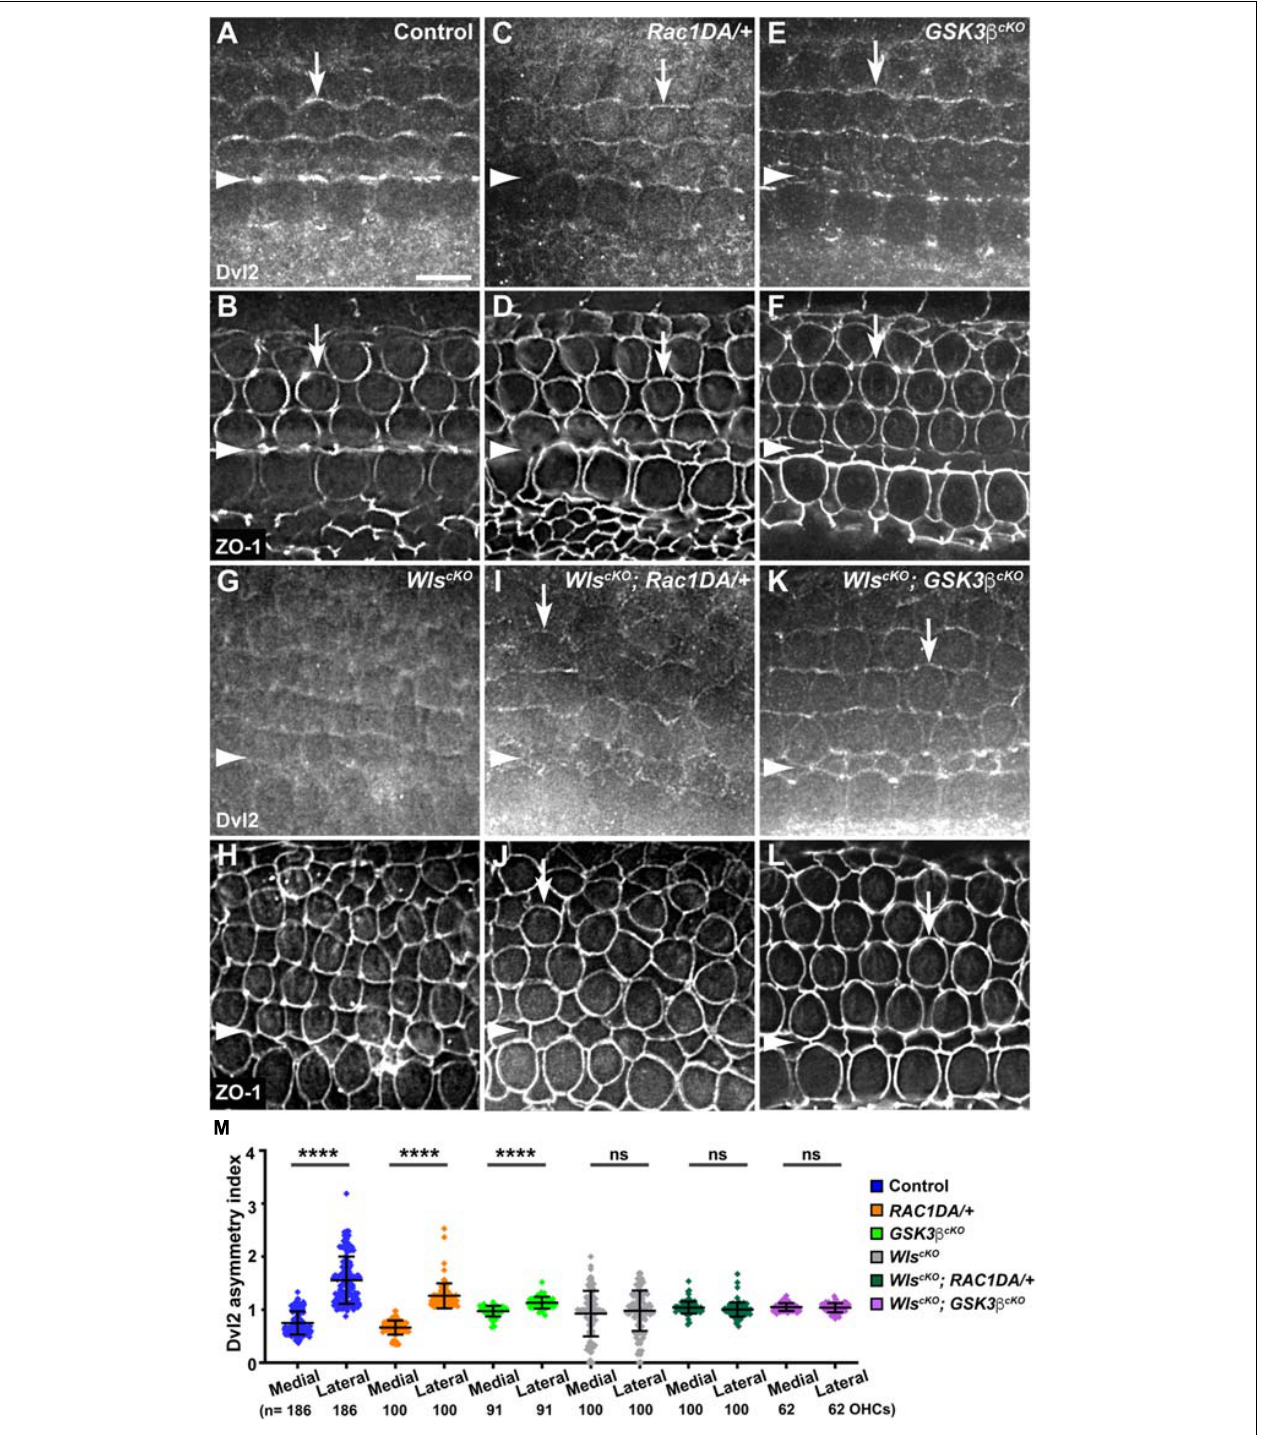
FIGURE 6 | Effects of Rac1 activation and Gsk3 β inactivation on Dvl2 localization in Wls-deficient OC. (A–L) Flat-mounted E18.5 wild-type control (A,B) , Rac1DA/ + (C,D) , Gsk3 β cKO (E,F) , Wls cKO (G,H) , Wls cKO ; Rac1DA/ + (I,J) , and Wls cKO ; Gsk3 β cKO (K,L) OC stained for Dvl2 and ZO-1 as indicated. Arrows indicate Dvl2 crescents along the lateral borders of OHCs. Arrowheads indicate the inner pillar cell row. Lateral is up. Scale bar: 6 µ m. (M) Quantifications of Dvl2 staining along the medial and lateral junctions of OHCs. Numbers of OHCs scored are indicated on the bottom. Color keys for genotypes are indicated on the right. Ns, not significant.